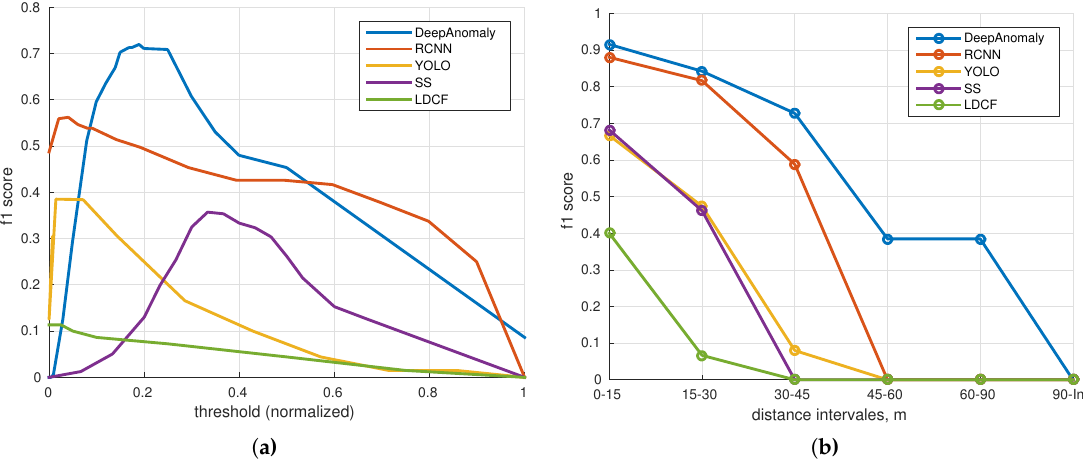
Figure 16. Accuracy performance (f1 score) of DeepAnomaly and four state-of-the-art object detection algorithms. ( a ) Accuracy relative to thresholds; ( b ) accuracy relative to distance intervals. Table 2. Comparison of of DeepAnomaly with four state-of-the-art algorithms for obstacle detection. YOLO, you only look once; SS, semantic segmentation; LDCF, local decorrelated channel